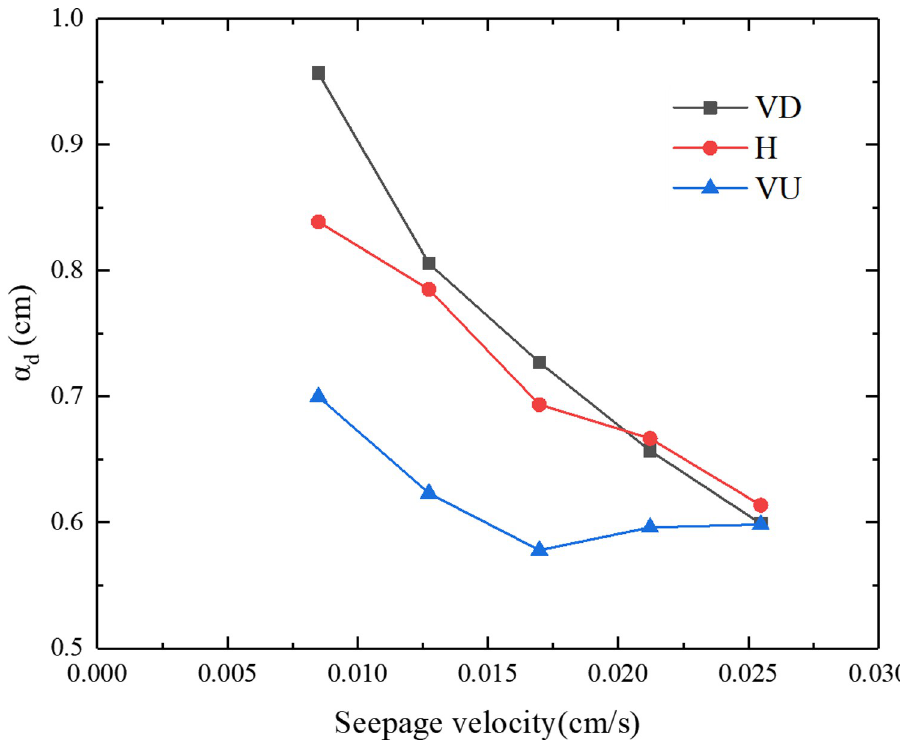
Fig 8. The relationship between the dispersion and seepage velocity of the porous media under three different seepage